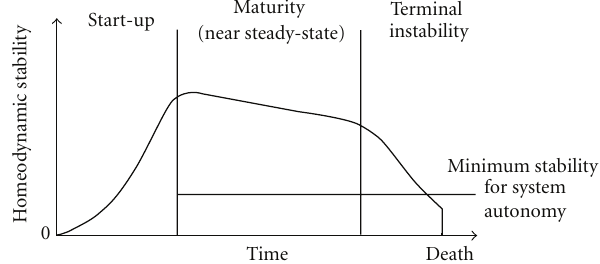
Figure 2: Homeodynamic stability as a function of time in a self- organizing system [19].